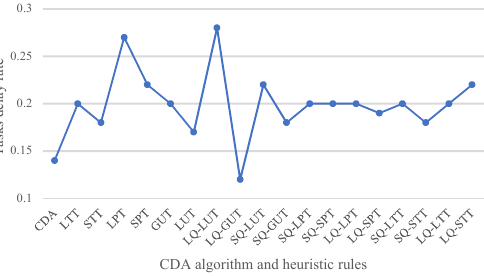
Figure A4. Curve of tasks delay rate of CDA algorithm and assignment rules under different